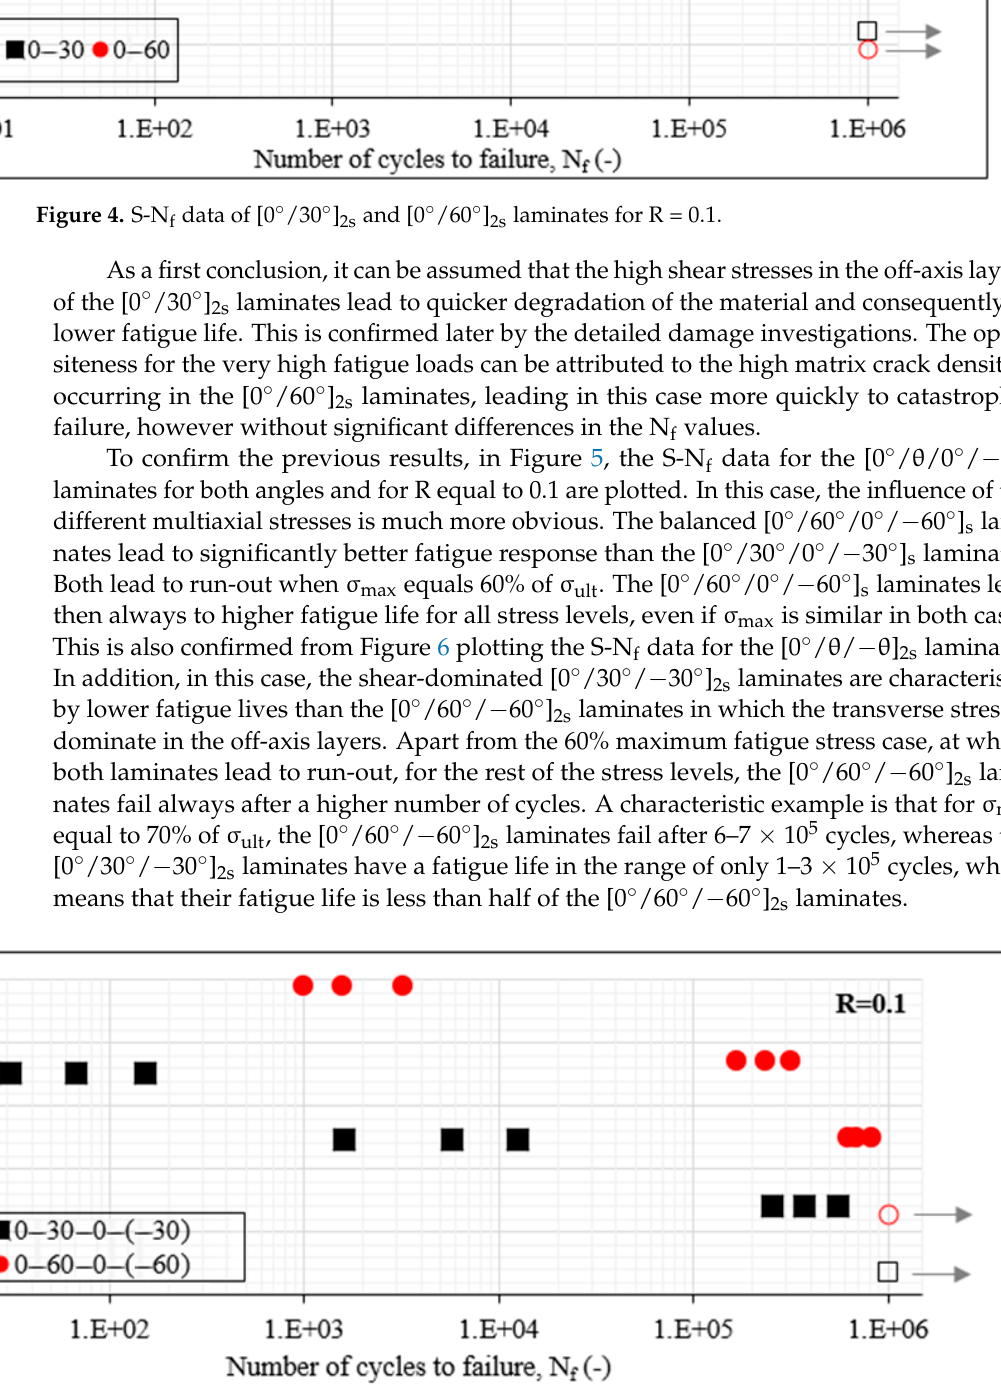
Figure 5. S-N f data of [0°/30°/0°/ − 30°] s and [0°/60°/0°/ − 60°] s laminates for R = 0.1.